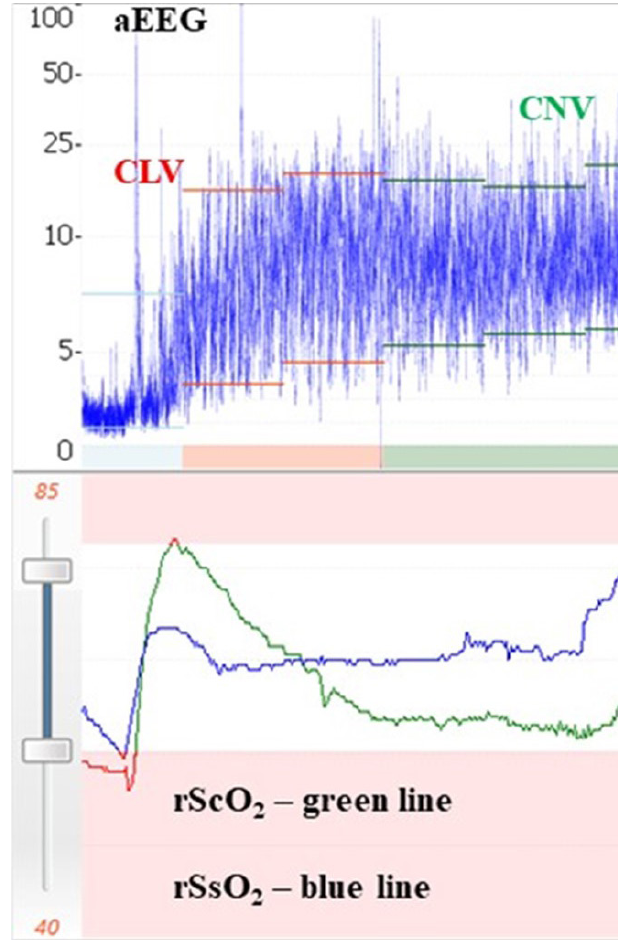
Fig. 5 - Recovery of cerebral (rScO2) and somatic (rSsO2) regional oximetry in a neonate after cardiovascular arrest during Transposition of Great Arteries repair with simultaneous electrophysiologic recovery accessed by amplitude-integrated electroencephalogram (aEEG). CLV=continuous low voltage; CNV=continuous normal